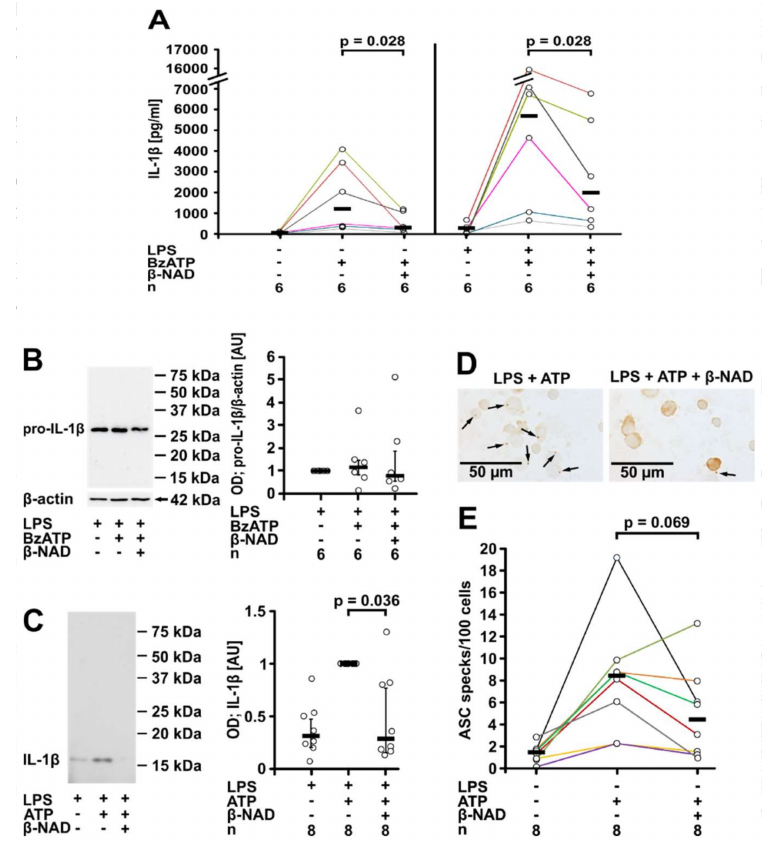
Figure 2. β -NAD inhibits ATP-induced IL-1 β release by primary peripheral blood mononuclear leukocytes (PBMCs). ( A – C ) PBMCs from healthy donors were left untreated or pulsed with LPS (5 ng/mL) during the process of leukocyte isolation, cultured for 3 h, and stimulated with BzATP (100 µ M, 30 min) in the presence or absence of β -NAD (1 mM). ( A ) The concentration of IL-1 β was measured in the cell culture supernatant by ELISA. ( B , C ) Western blot analysis of cell lysates or concentrated cell culture supernatants using antibodies that recognize pro-IL-1 β and mature IL-1 β . ( B ) Representative Western blot of cell lysates; pro-IL-1 β is detected with an apparent molecular mass of about 34 kDa. A faint signal corresponding to mature IL-1 β was obtained in lysates of cells treated with BzATP and β -NAD only in one out of 6 blots. β -actin (40 kDa) was detected on the same blots as a loading control. ( C ) Representative Western blot of cell culture supernatants (one out of 8); only mature IL-1 β is detected with an apparent molecular mass of 17 kDa. The optical density (OD) of the immuno-positive bands was measured and the values of the samples from cells stimulated with LPS and BzATP were set to one arbitrary unit (AU). Data are presented as individual data points, bars indicate median, whiskers encompass the 25th to 75th percentile. ( D , E ) LPS-pulsed PBMCs were stimulated with ATP (1 mM) and again, β -NAD (1 mM) was added in some experiments. ( D ) ASC immunoreactivity in adherent PBMCs was detected in brown color by immunocytochemistry; arrows are pointing to ASC specks. ( E ) The number of ASC specks per 100 PBMCs was quantified. Data points from individual blood donors are connected by lines in different colors, bars indicate median ( A , E ); Wilcoxon signed-rank